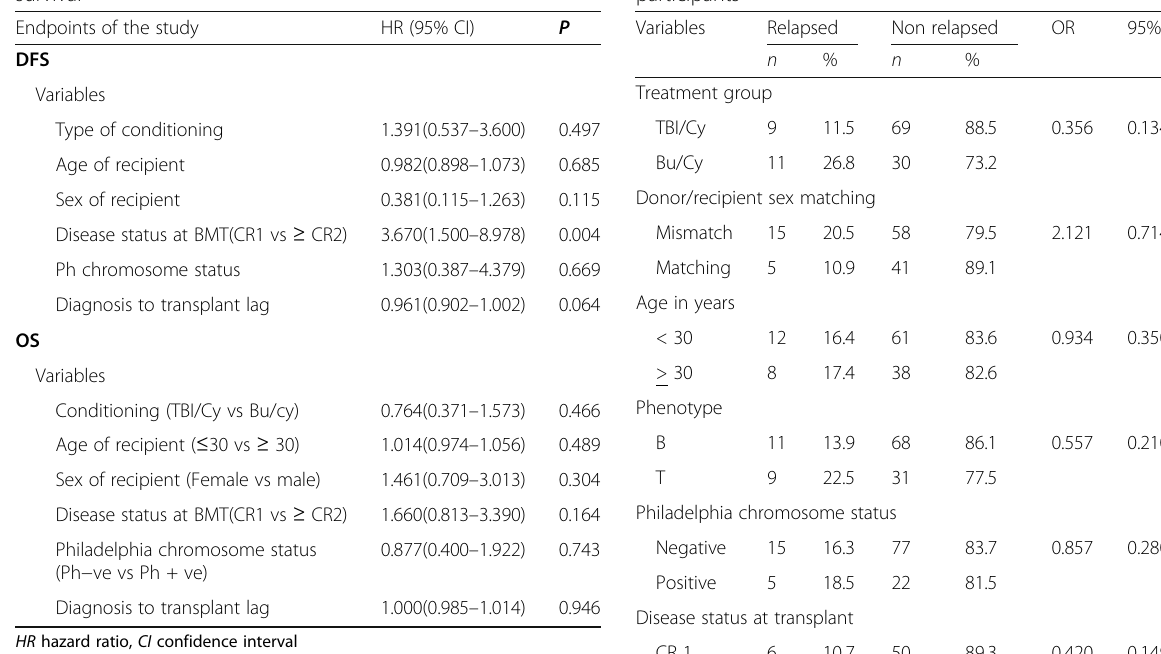
Table 5 Analysis of risk factors of relapse among